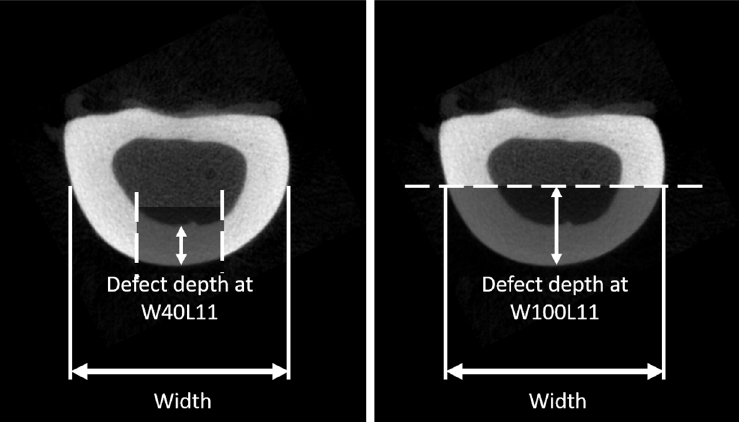
Table 1. Different cortical window sizes to test the effect of defect size on the stress distribution. The width of the radius is defined as projection width of the diaphysis as indicated in Figure 1.